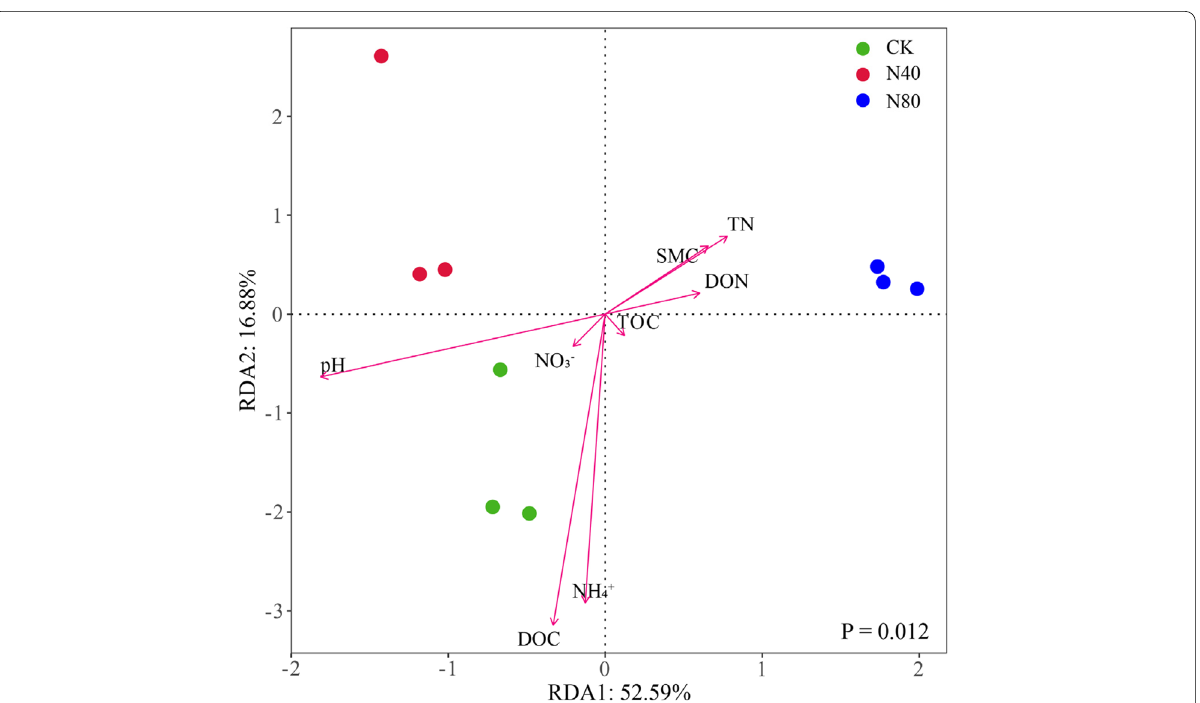
Fig. 5 Redundancy analysis of soil microbial community functions and environmental factors under different nitrogen addition treatments. CK , control; N40 , 40 kg N ha − 1 a − 1 ; N80 , 80 kg N ha − 1 a − 1 . SMC , soil moisture contents; DOC , dissolved organic carbon; DON , dissolved organic nitrogen; TN , total nitrogen; TOC , total organic carbon